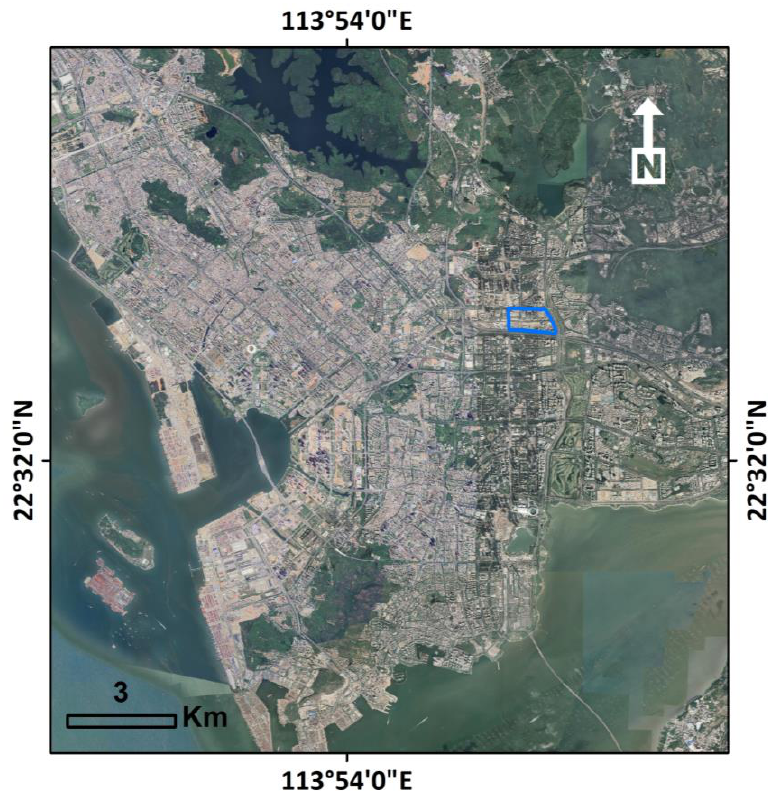
Figure 3. The stable region (marked by the blue polygon) that serves as the spatial reference for resolving the phase time series.